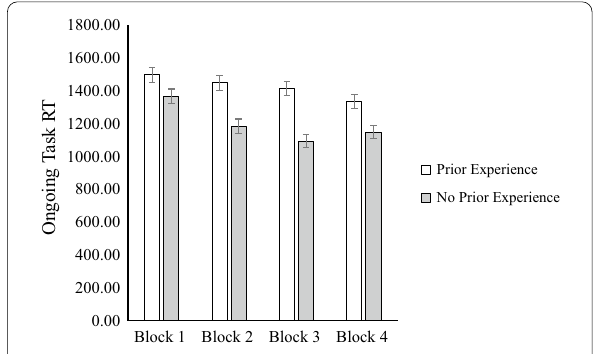
Fig. 2 Ongoing task response time across blocks by experience condition in Experiment